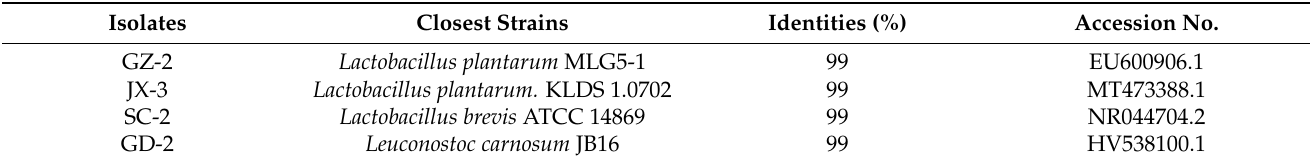
Table 7. 16S rDNA sequences similarities of isolated strains with representative microbe.